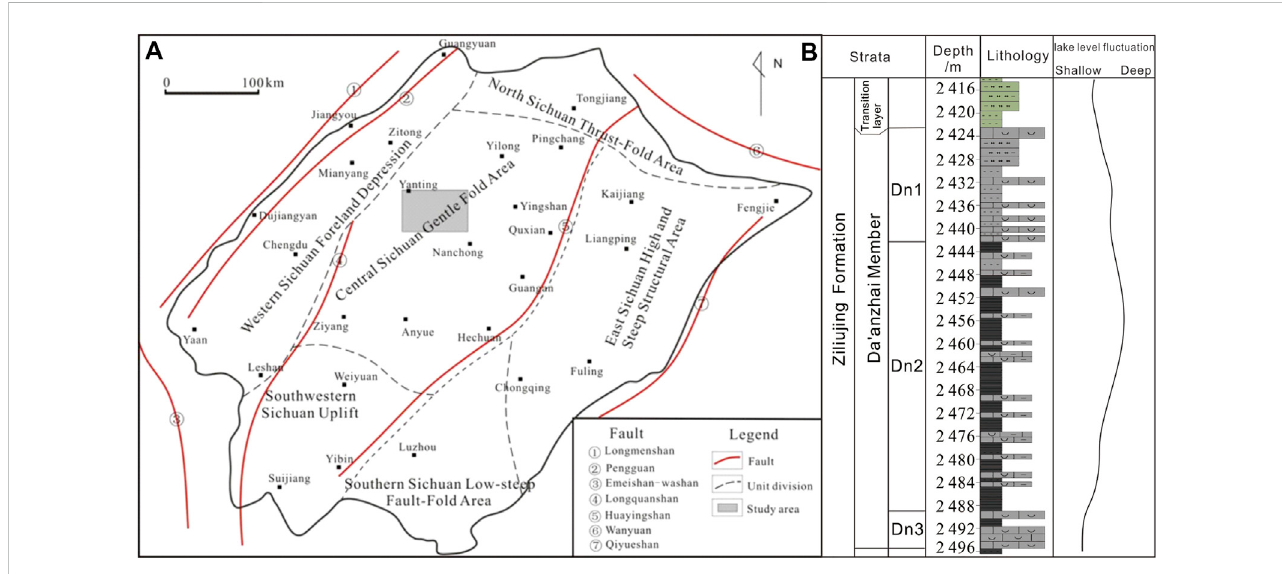
FIGURE 1 (A) Regional geology map of the Sichuan Basin marking the study area and (B) the stratigraphic column of the Da ’ anzhai Member of the Ziliujing Formation.